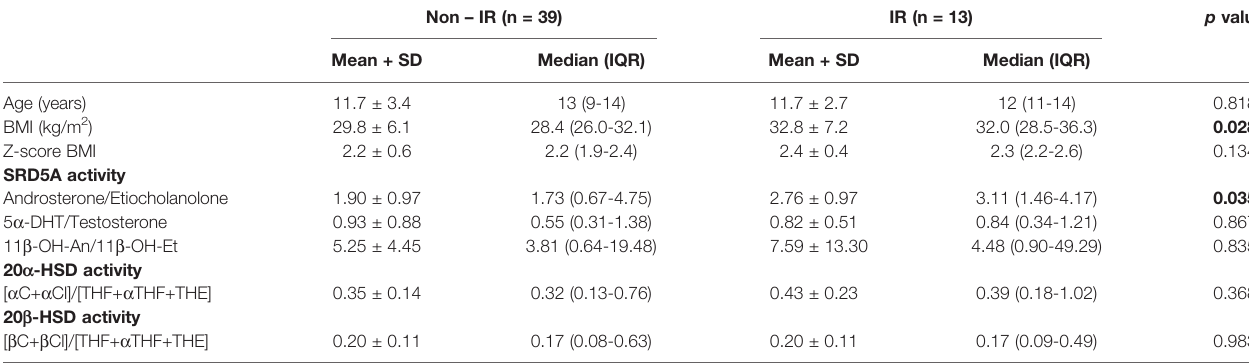
TABLE 4 | Ratios of steroid metabolites (indicative of enzyme activity): comparison between obese boys with and without insulin resistance